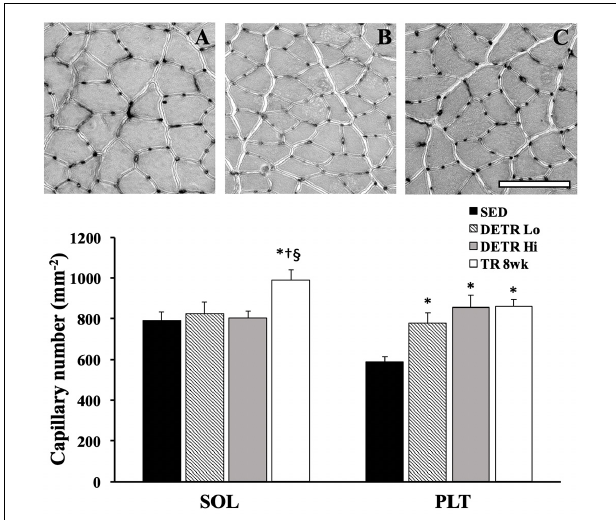
FIGURE 3 | Total capillary number (per mm 2 ) in SED, detrained (DETR), and trained (TR) soleus and plantaris muscles of adult female rats. DETR consisted of 4 weeks of voluntary running followed by 4 weeks of SED conditions and were categorized as high- (DETR Hi) or low- (DETR Lo) total running distances. Exercise-trained rats ran for 8 weeks (TR 8wk). Representative lead-nitrate-based histochemistry from SED (A) , DETR Hi (B) and TR 8wk (C) plantaris muscle cross sections are shown; scale bar = 100 µ m. Values are means ± SEM. Significant differences from SED ( ∗ ), DETR Lo ( † ), and DETR Hi ( § ) are indicated; significance was set a p <